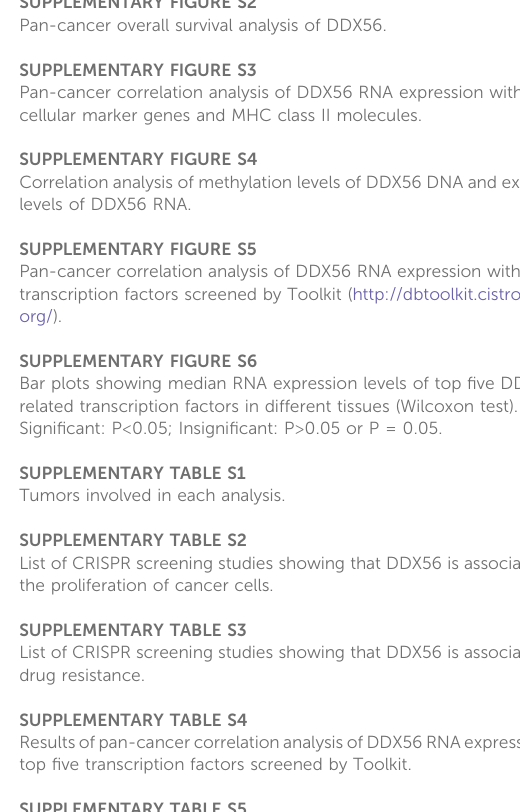
List of CRISPR screening studies showing that DDX56 is associated with drug